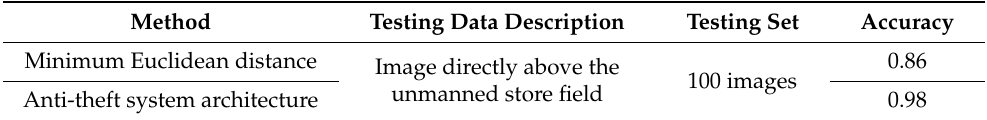
Table 6. Accuracy rates using Euclidean distance and OpenPose anti-theft system. Method